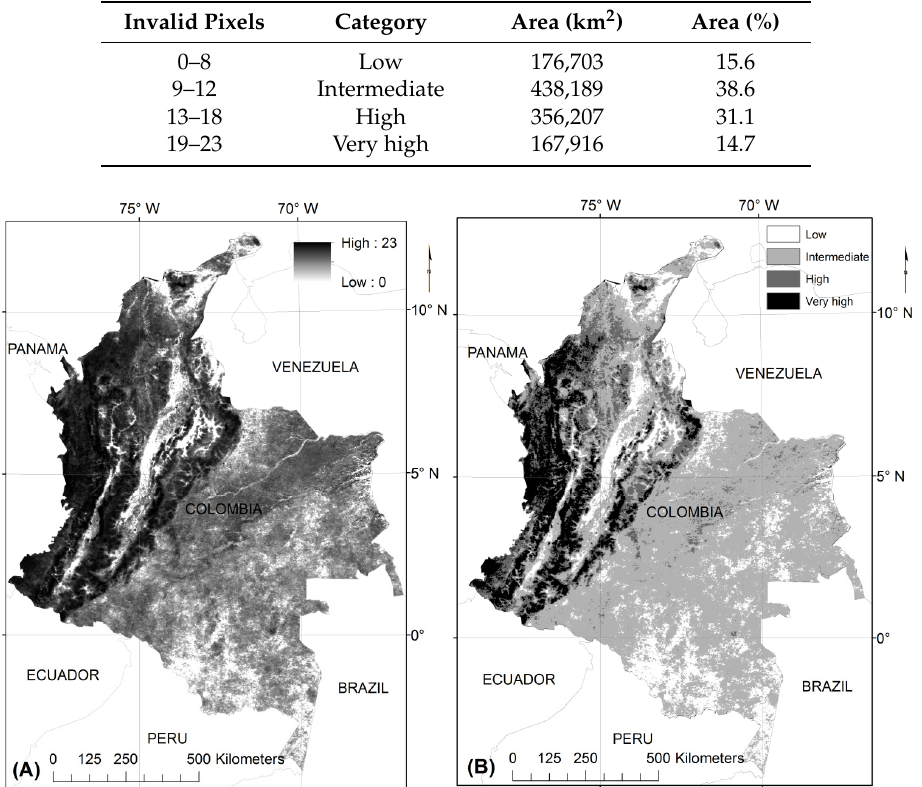
Multi-year data integration allows a better reconstruction of phenological patterns of vegetation classes. Figure 4 shows the effect of eliminating invalid pixels and adding data from adjacent years for two pixels representing evergreen broadleaf forest and savannas, where the color of large filled circles indicates the compositing step with data from 2011 ± 1 year and 2011 ± 2 years. In both cases time series are improved by replacing invalid values, but the use of the importance of the multi-year approach is best noted for temporal profiles with seasonal cycles due to vegetation phenology. For the evergreen broadleaf forest site in Figure 4A there is, as expected, no seasonal dynamic; thus, there are only minor modifications by multi-year data integration as compared to time series generation using data from 2011, only. For the savanna site in Figure 4B there is a moderate seasonal dynamic, responsive to low precipitation. Invalid data was drastically reduced when using compositing with adjacent years. Both the mean and the standard deviation (shown in parenthesis) were reduced; for 2011 the mean invalid data without compositing was 54.9% (17.9%), which reduced to 25.0% (11.5%) for 2011 ± 1 year and 15.2% (6.3%) for 2011 ± 2 years. This reduction was more evident for 16-day composites with the highest proportion of invalid pixels during the rainy season (composites 6–13 and 17–23 in Figure 5A). From the spatial point of view, the reduction occurs in all categories (Figure 5B). The area of no observation for the entire year was reduced from 24,130 km 2 (2.11%) in 2011 to 2890 km 2 (0.25%) for 2011 ± 1 year and to 1497 km 2 (0.13%) for 2011 ± 2 years.